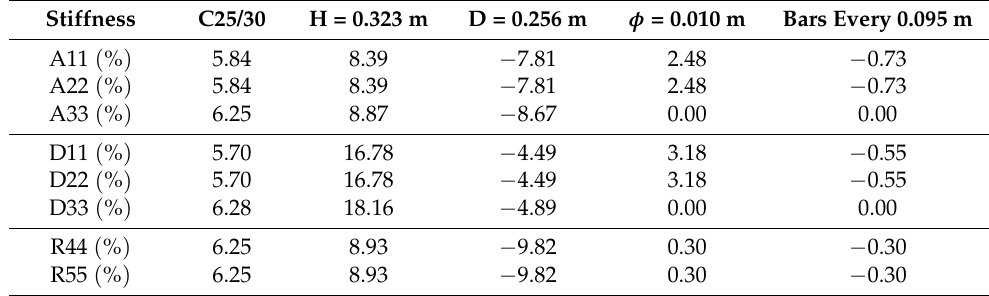
Table 8. Normalized stiffness for RVE